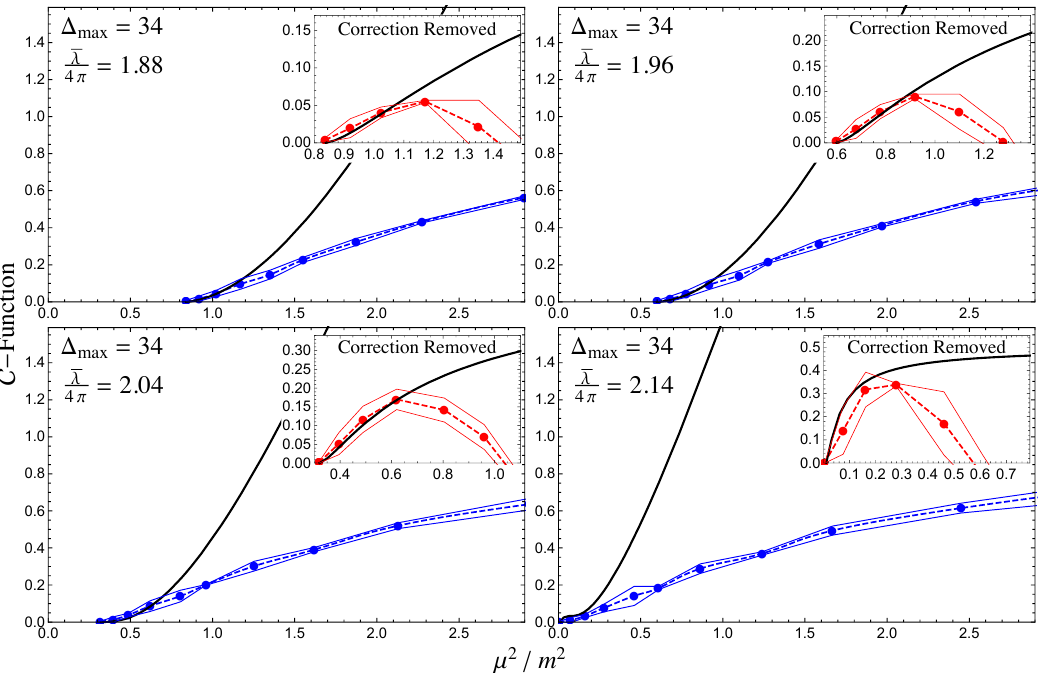
Figure 13 . Zamolodchikov C -function for (cid:1) max = 34 and di(cid:11)erent values of (cid:22) (cid:21) . The thin lines surrounding the data points indicate the magnitude of the di(cid:11)erence between these results and those at (cid:1) max = 30, providing a rough estimate of the convergence. Main plots: raw data (blue dots) compared to the Ising model prediction (black curve), which includes the correction from the leading irrelevant operator (with (cid:3) = 1 : 0). Insets: same data points, but with the expected leading m correction removed (red dots), compared with the Ising model prediction (black curve).